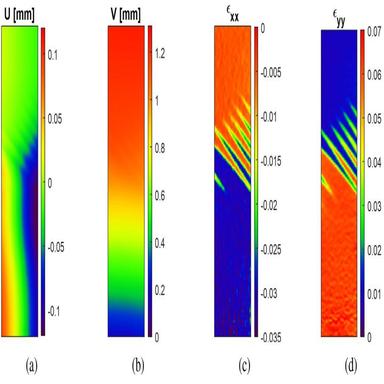
(a) Horizontal displacement map; (b) vertical displacement map; (c) horizontal strain map; (d) vertical strain map.